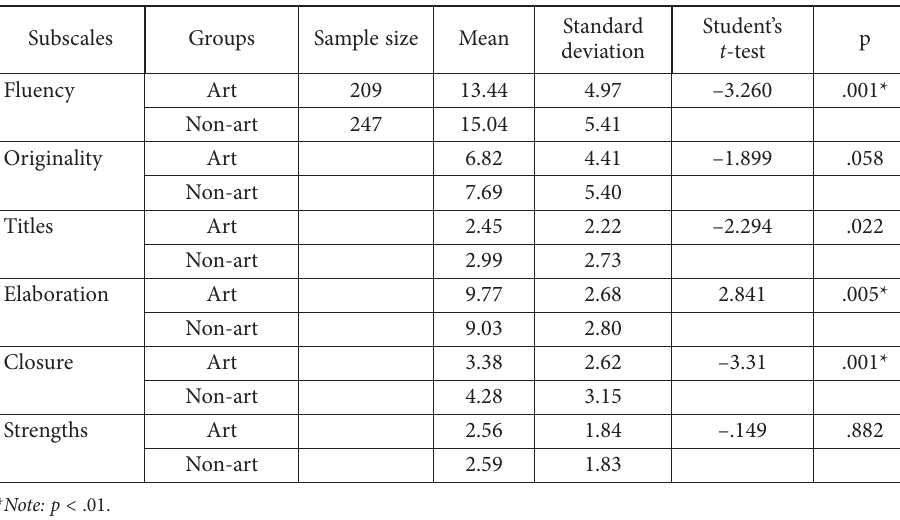
Table 5. Student’s t -test results between two groups in terms of creative thinking subscales (source: created by